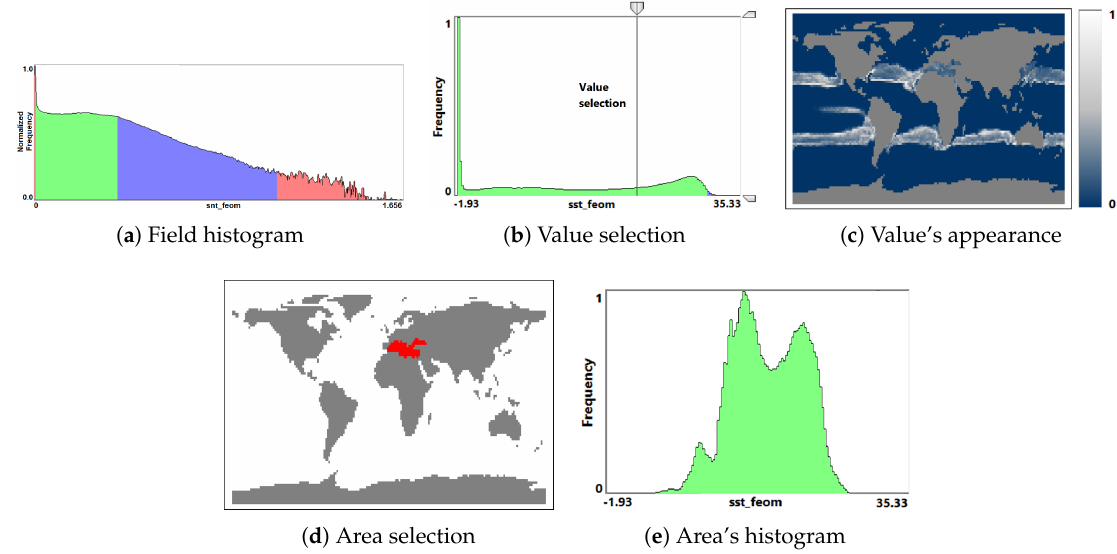
Figure 15. ( a ) Field distribution histogram for sea snow thickness in global climate simulation. ( b ) Interactive selection of a field value and linked visualization ( c ) of its distribution of appearance. ( d ) Interactive selection of a domain area and linked visualization ( e ) of its field